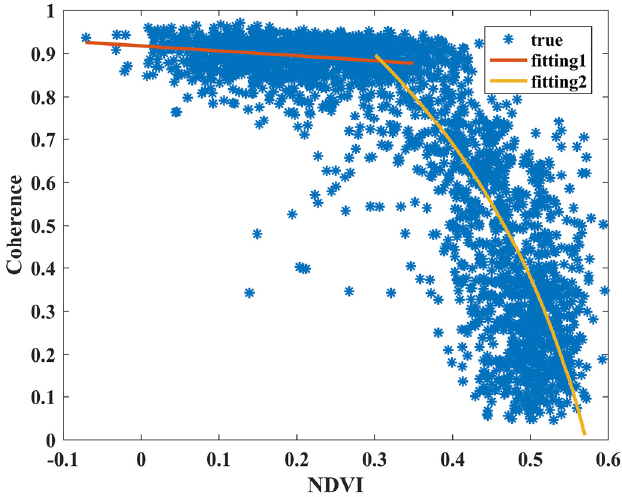
Figure 4. Correlation between Landsat5/NDVI and PALSAR-1/coherence.